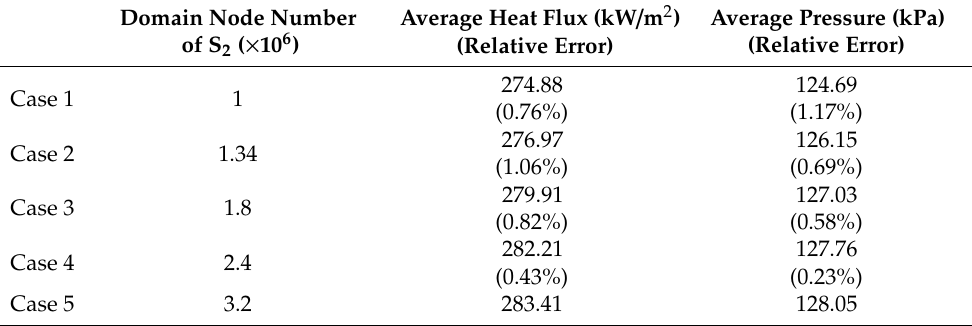
Table 1. Grid-independent